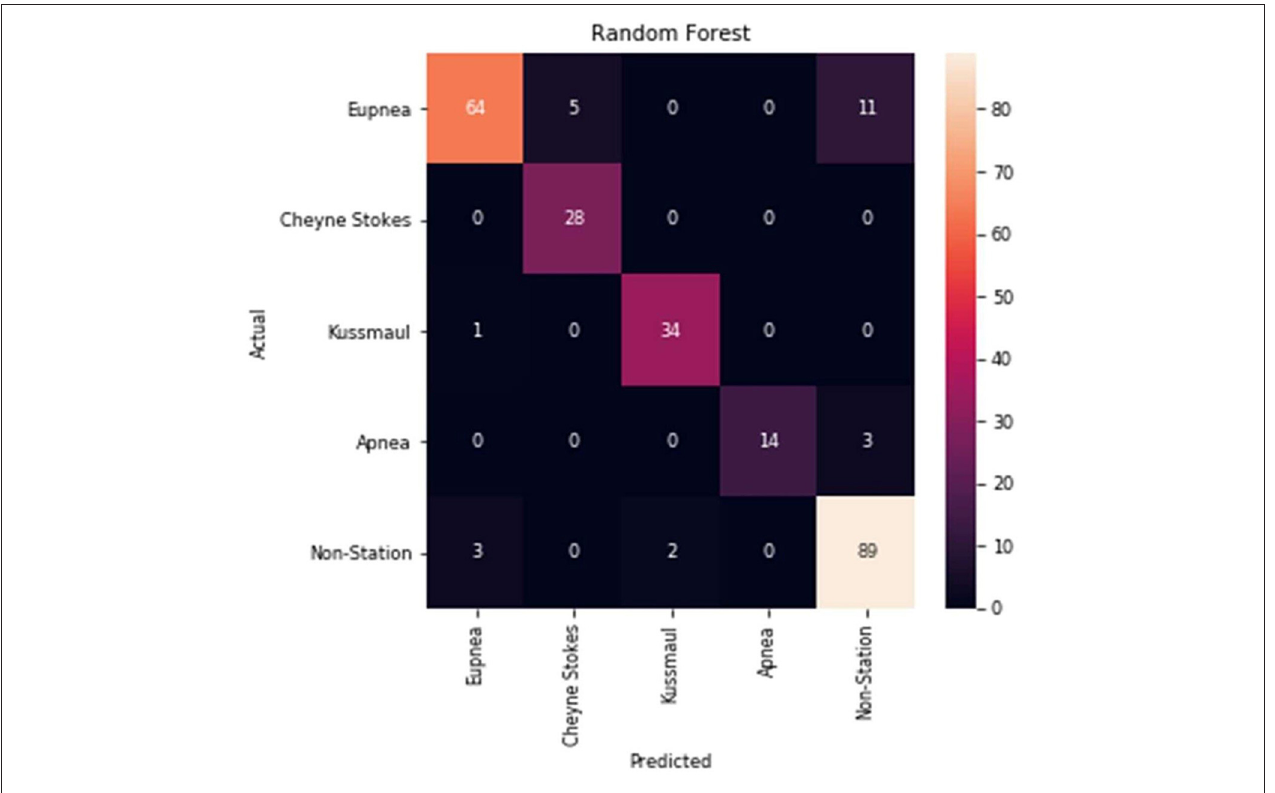
FIGURE 9 | Confusion matrix of the classification model.